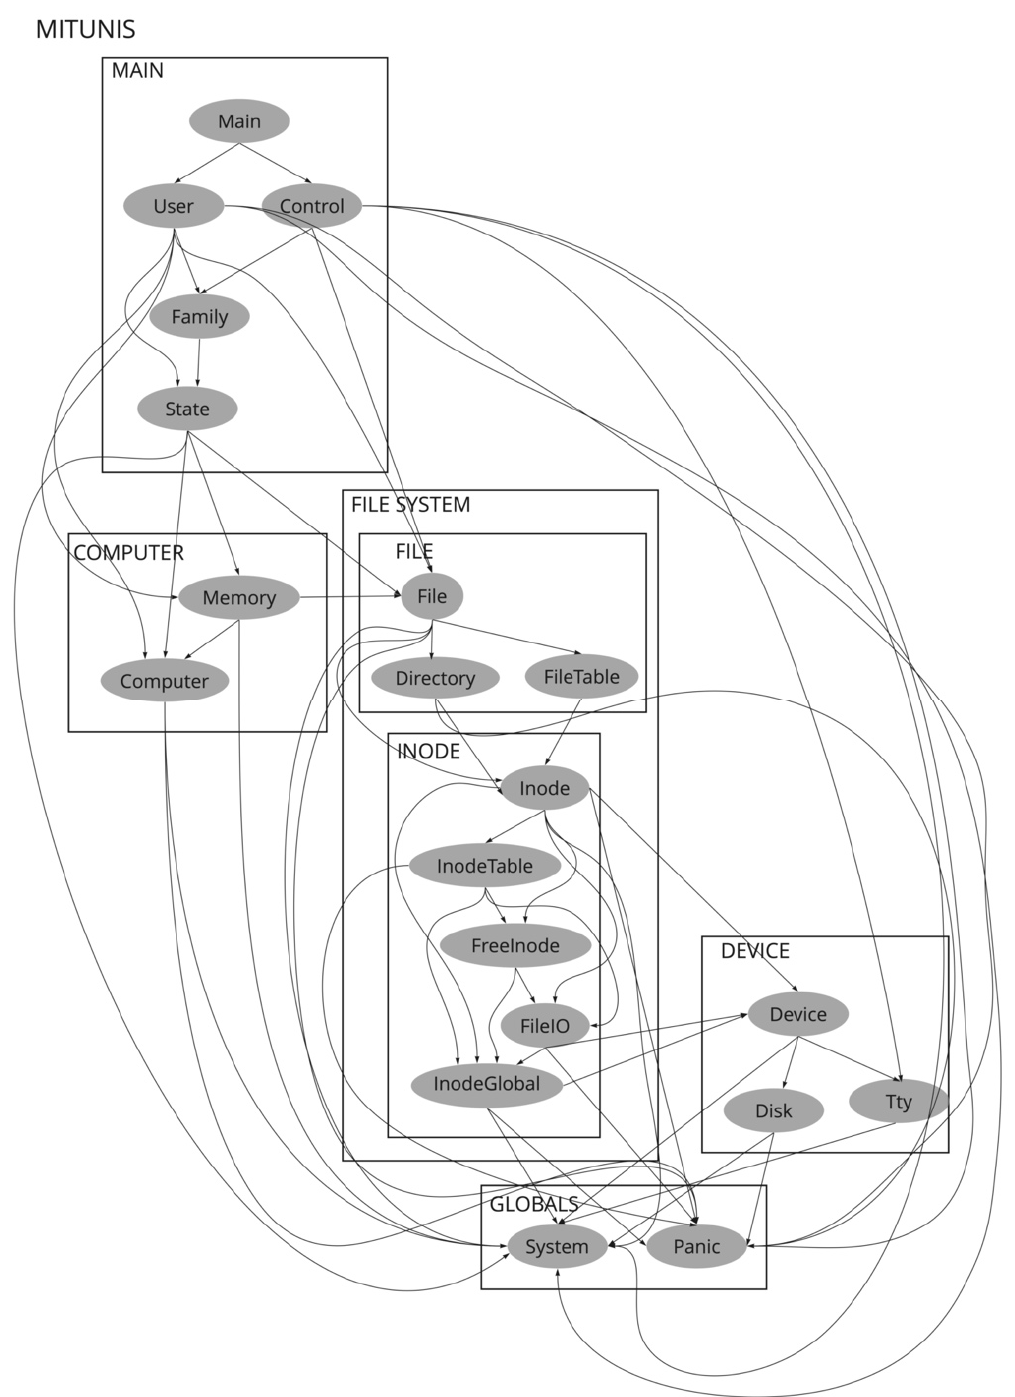
Figure 6. Mutins system before applying the HHMO_CF_GDA approach. Adapted from [31].